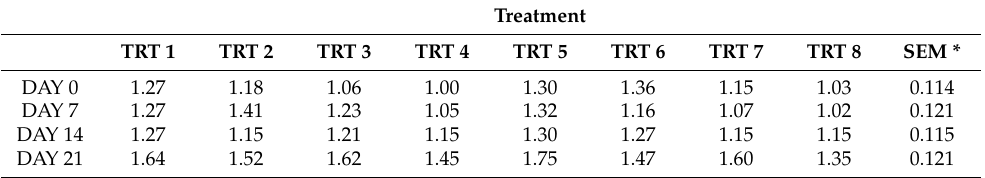
Table 5. Influence of packaging film and lean trimmings on amount of browning color evaluator ratings of ground beef during a simulated retail display shelf life.